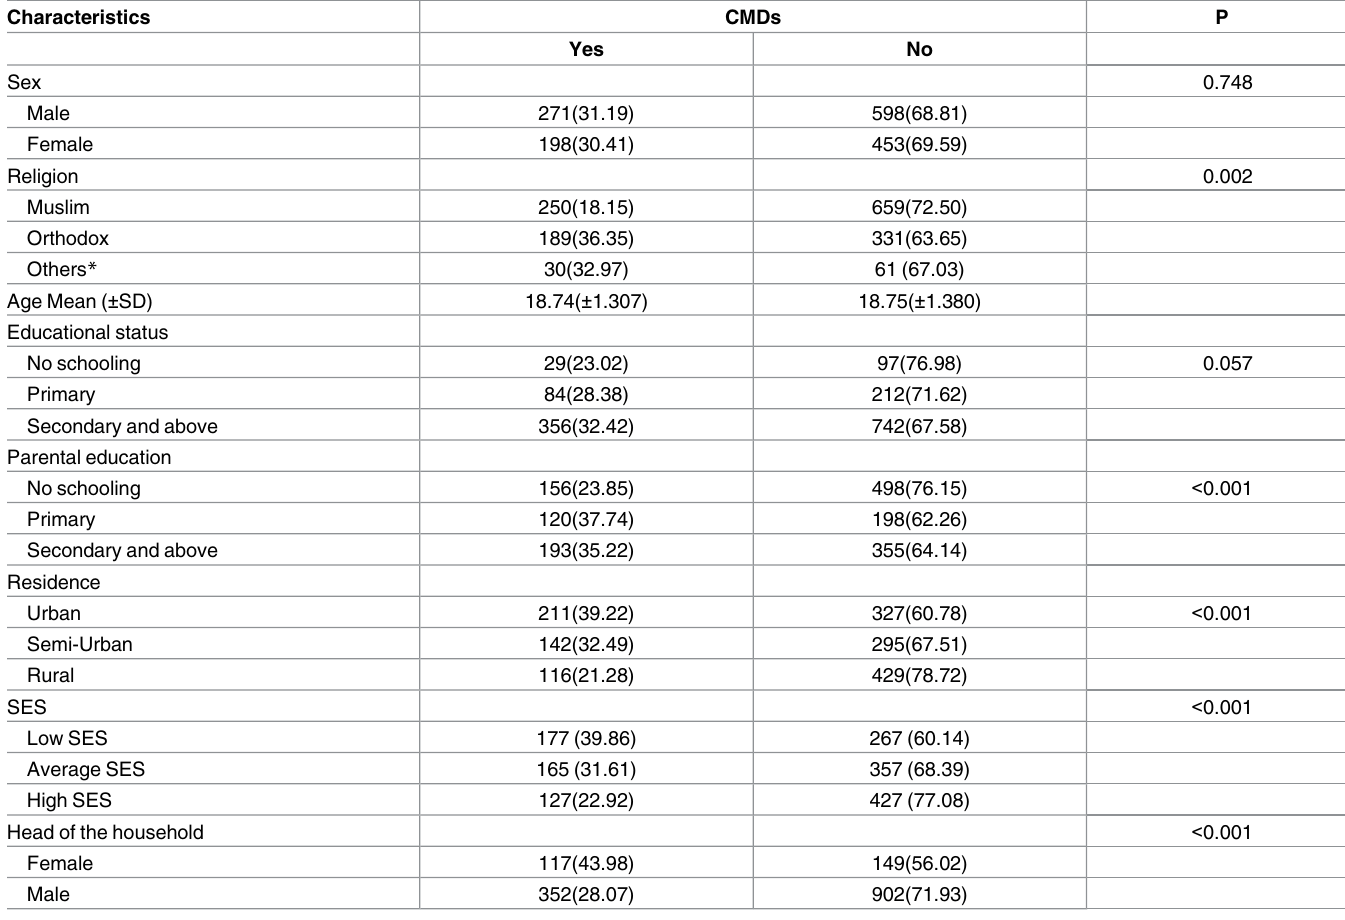
Table 1. Socio demographic characteristics of Youth (n = 1,521), Jimma Longitudinal Family Youth Survey (JLFSY), Southwest Ethiopia, 2015.